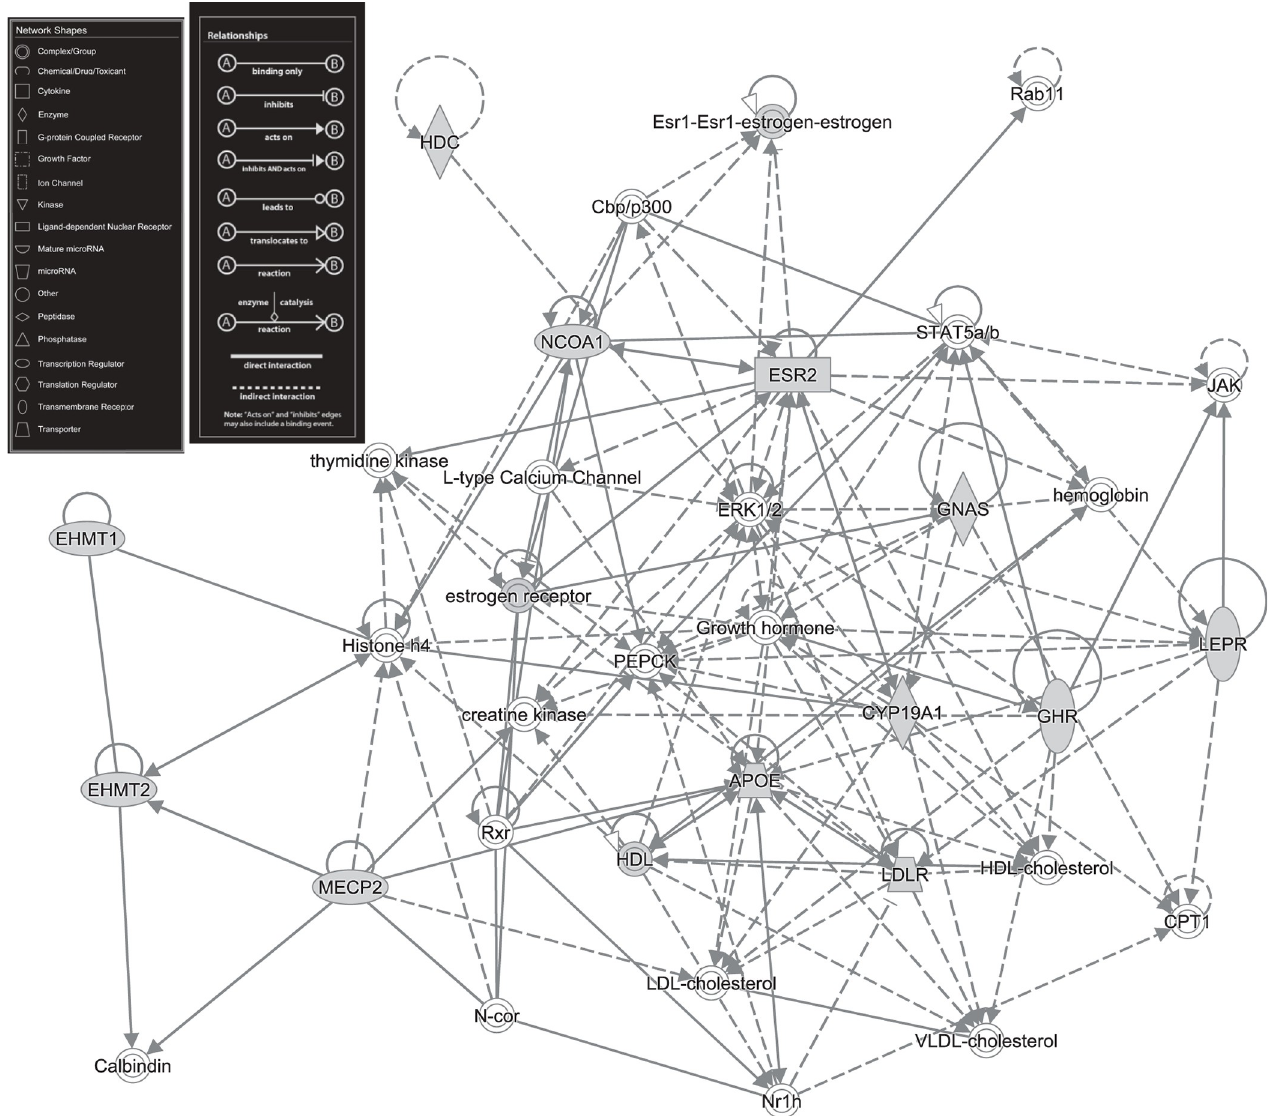
Fig 2. Pathways common to obesity and dementia. Ingenuity pathway analysis demonstrates that 12 of the 15 genes identified to be at the intersection of two often co-occurring conditions, obesity and dementia, map to one